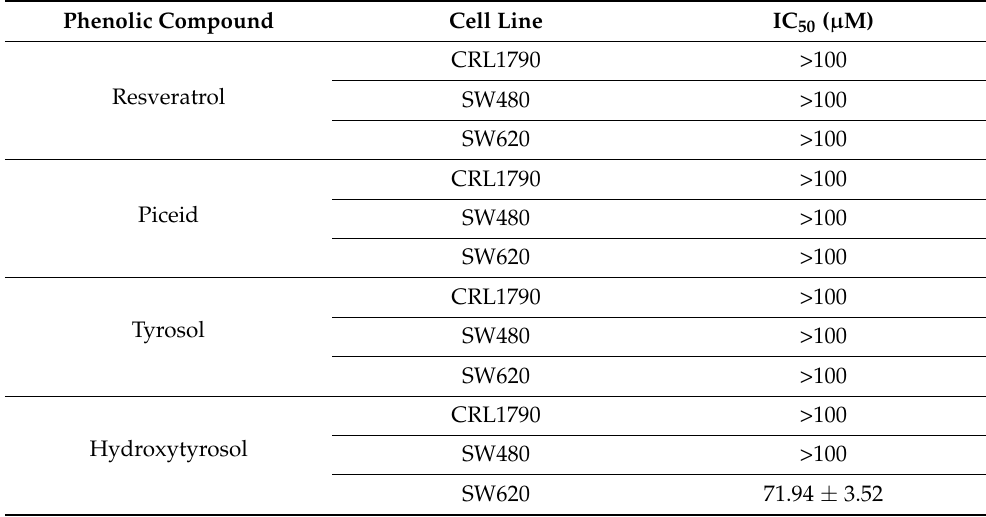
Table 1. IC 50 values for phenolic compounds in the cellular model of CRC. IC 50 values represent phenols concentration inhibiting cell growth by 50% and are expressed as mean ± standard deviation. Experiments were performed in biological